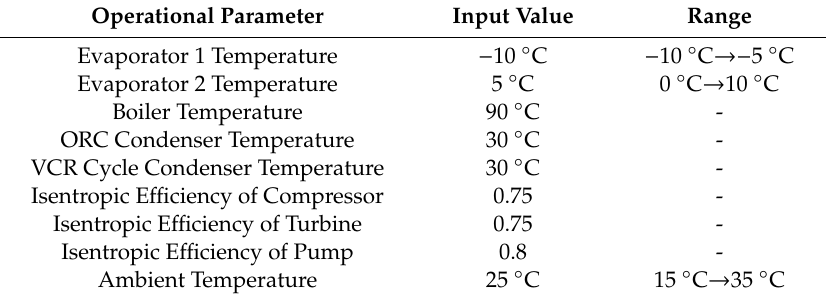
Table 3. Input values and ranges of operational parameters used in the second system.